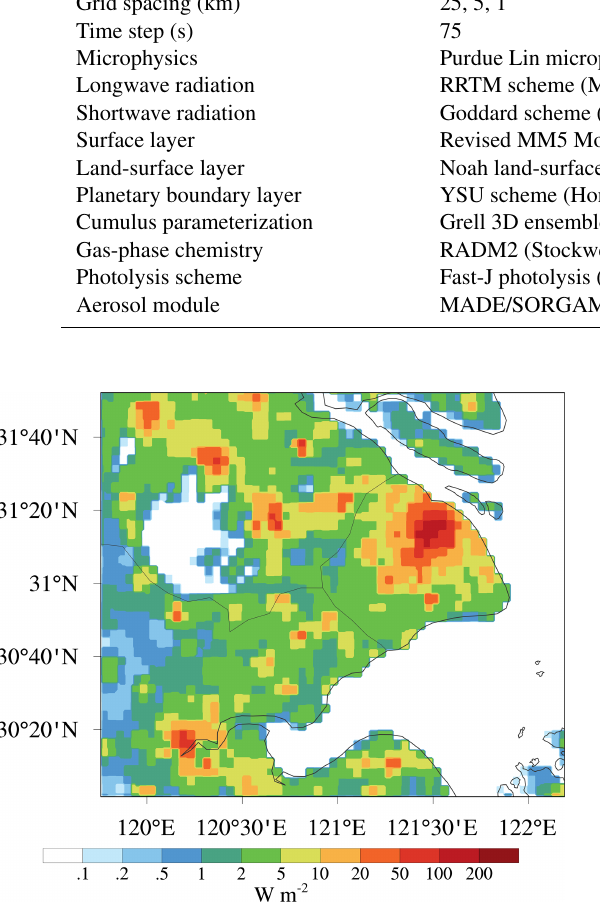
Figure 3. Spatial distribution of anthropogenic heat fluxes in the innermost domain. Table 2. The three numerical